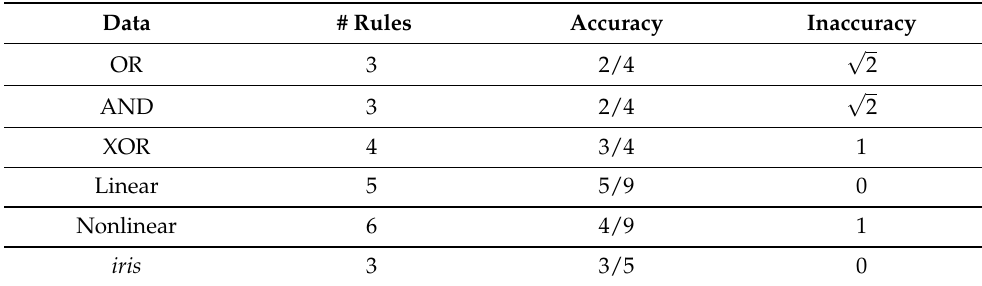
Table 6. Statistic data of the extracted fuzzy rules. Data # Rules